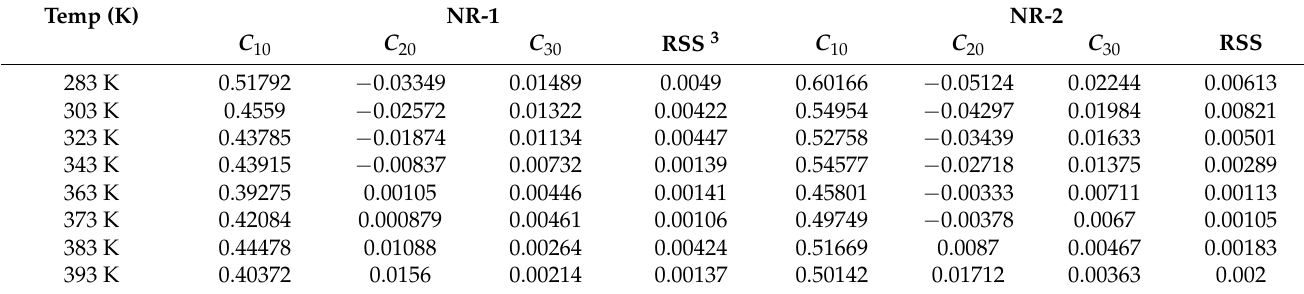
Table 3. Fitting parameters of Yeoh model to experimental data of filled rubber at different temperatures. Temp